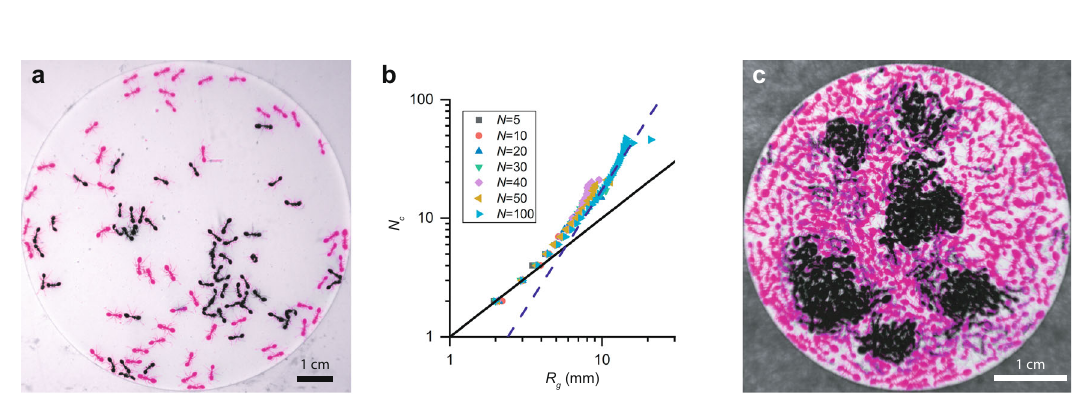
Fig. 2| Comparisonofeffectivepotentials.a – c The PMF(leftaxis, bluetriangles)and motility-induced effectivepotential(rightaxis,red circles)fortrialswith N =3,10, and 40 ants, respectively.